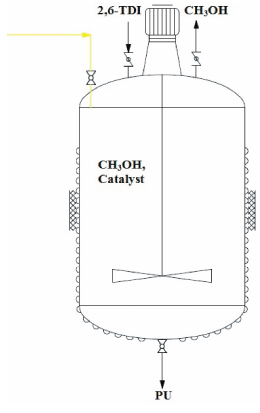
Figure 6. Pilot apparatus [49].